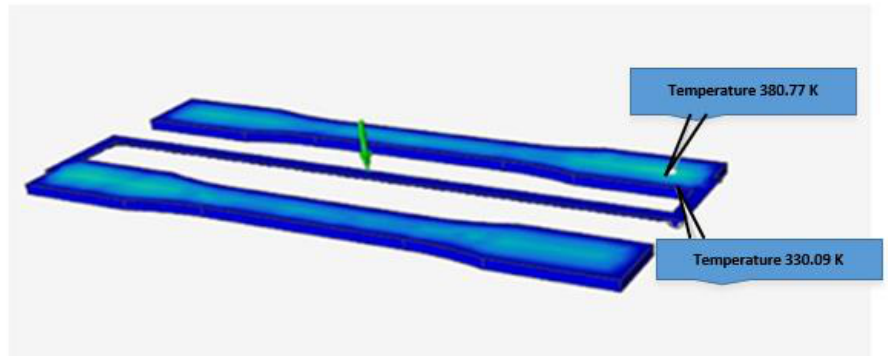
Figure 9. Simulations of two single-point temperatures in a specimen instrumented with a thermocouple: specimen surface (top) and area in contact with the mold cavity and the inserted thermocouple (bottom).